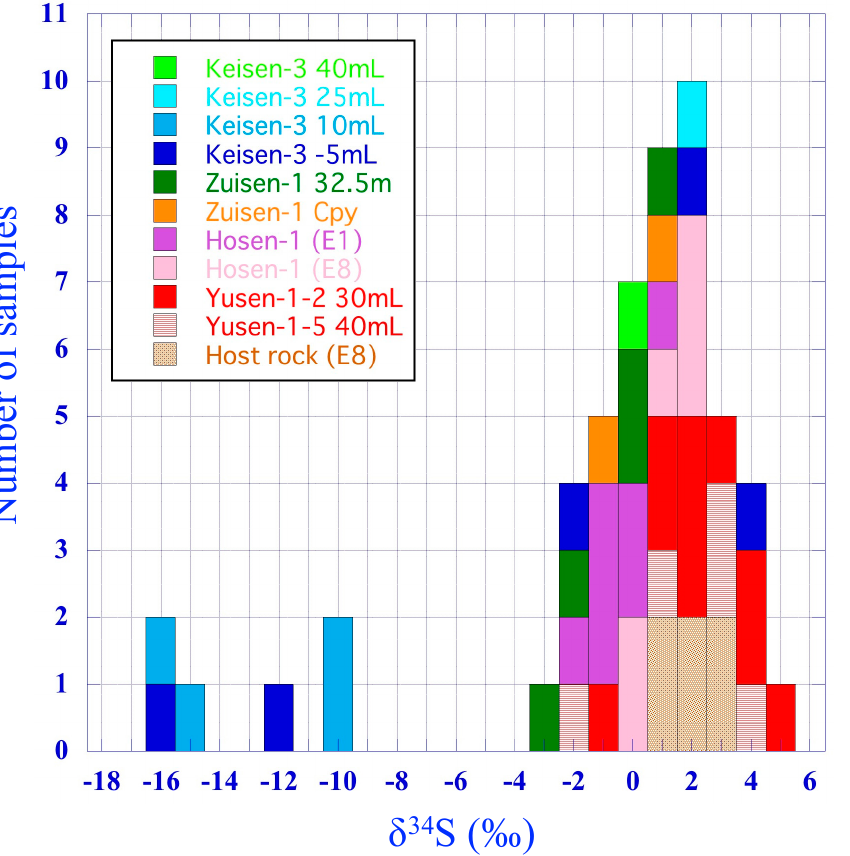
Figure 10. A histogram of δ 34 S values of pyrite and chalcopyrite from the Hishikari deposit using the SIMS microanalysis is shown based on Table 5. The vertical axis is the number of samples. The Keisen vein is from the Sanjin ore zone, the Zuisen and Hosen veins with the host rocks are from the Honko ore zone, and the Yusen veins are from the Yamada ore zone. The δ 34 S value for each vein is color-coded. The average δ 34 S value of whole data is − 0.7‰, and the average δ 34 S value of pyrites in veins is − 1.1‰. Pyrite grains in the sedimentary rocks (host rock in Figure 8) have slightly high δ 34 S values than those in quartz veins (Hosen-1) at the same location of E8. Cpy: chalcopyrite.